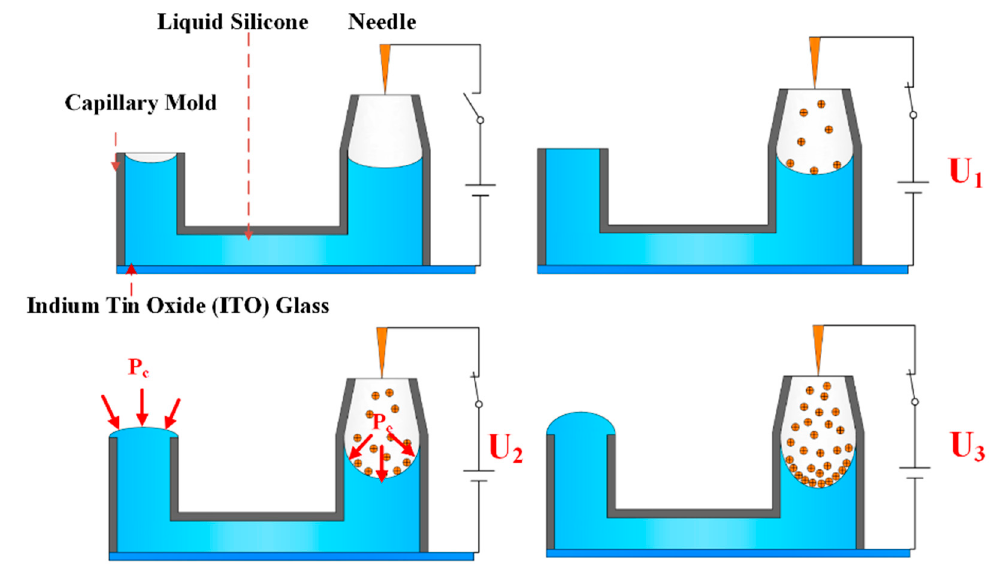
Figure 1. Principle of tunable-focus liquid lens by charge injection. As the imposed voltage increased (i.e., U 3 > U 2 > U 1 > 0), more positive ions accumulated at the air / liquid interface in the right-hand end of the tube, and the induced electropressure pushed the fluid toward the left-hand end of the tube.